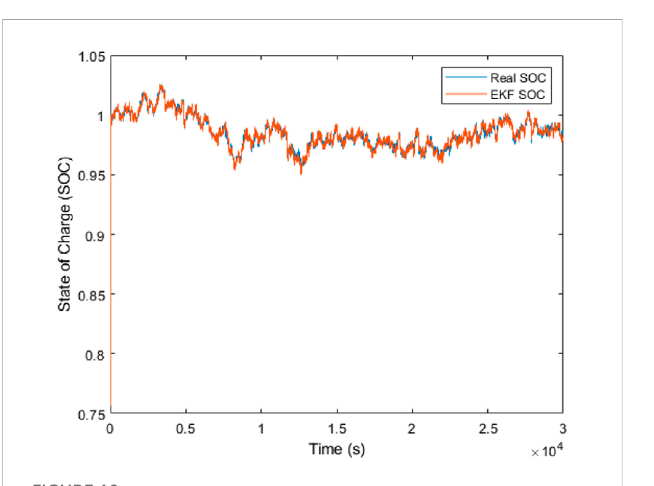
FIGURE 12 Hybrid estimator performance without the